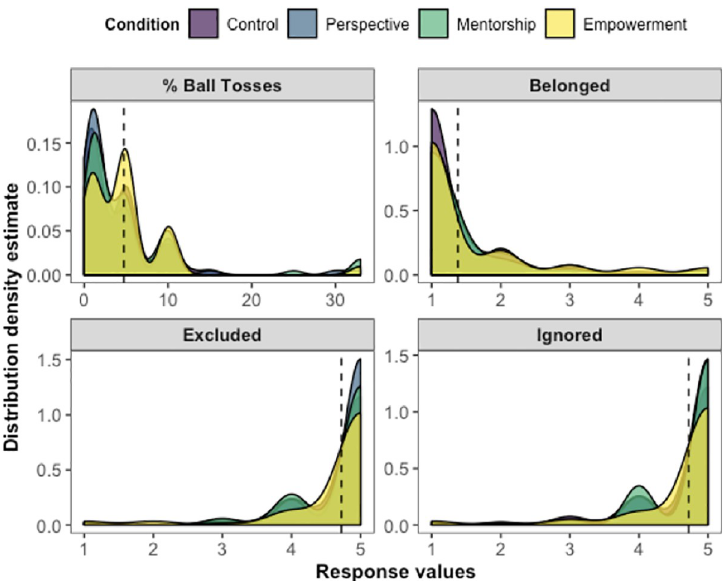
Fig 6. Distributions of manipulation check measures by intervention condition in Study 4. The main participants in Study 4 were only assigned to the exclusion condition in Cyberball. Dotted lines show the overall mean response value for each measure. There were no differences by intervention group for any of the measures. For estimating the percentage of ball tosses, participants typed a number between 0 and 100. For the questions on feelings of belonging, being excluded, and being ignored, participants answered using 5-point scales (1 = Not at all ; 5 = Extremely